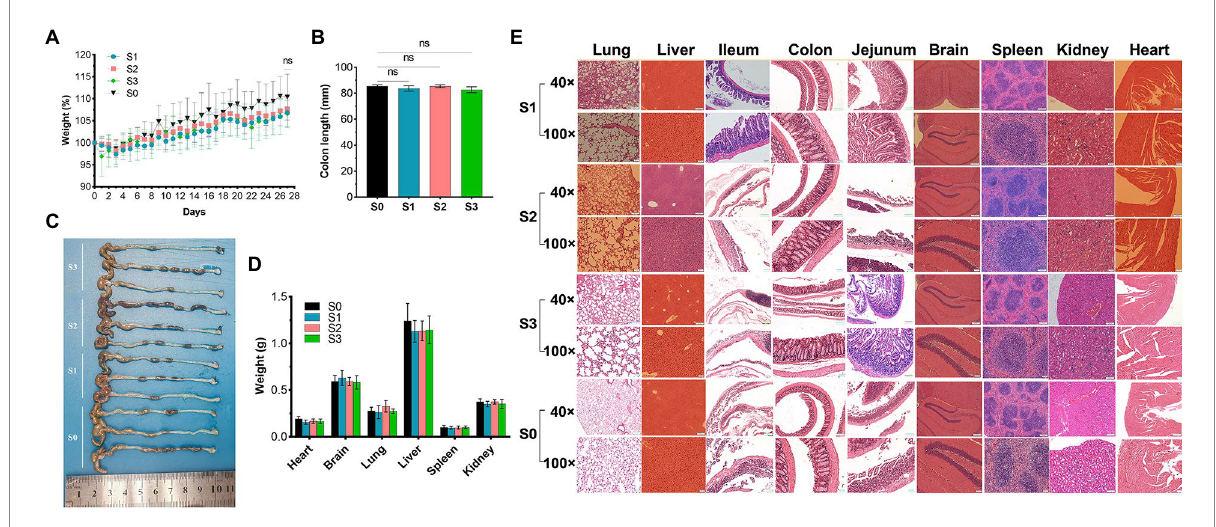
FIGURE 10 28-Day repeated dose study. (A) Body weight. (B,C) Colon length. (D) Weight of vital organs (heart, lung, brain, liver, spleen, kidney). (E) Hematoxylin–eosin staining pathological examination of organs. * indicates p < 0.05, ns indicates no